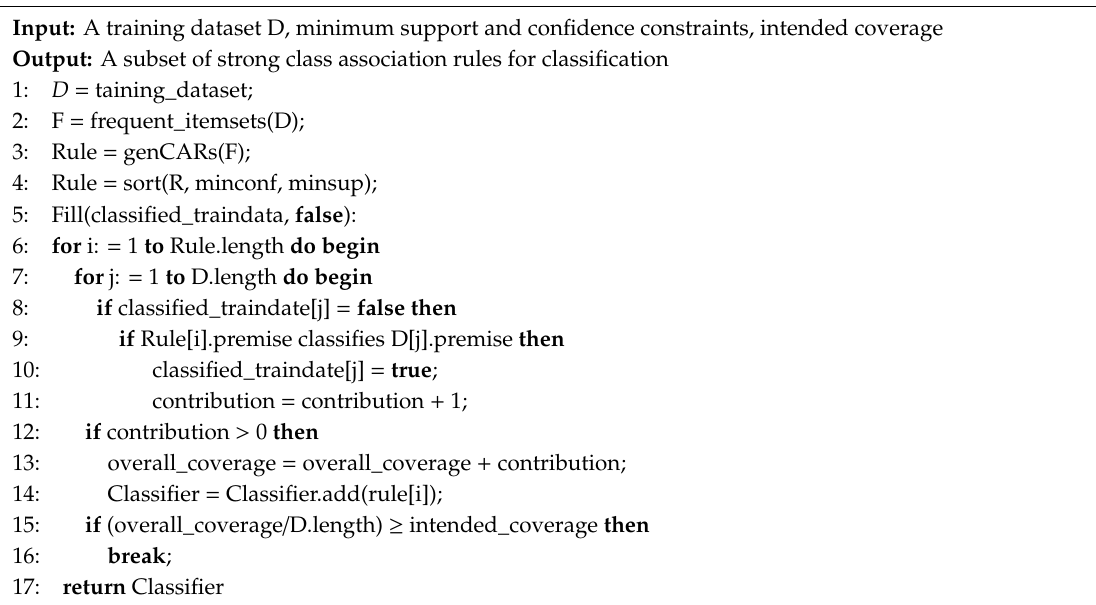
Algorithm 1: Building a compact and accurate classifier—J&B